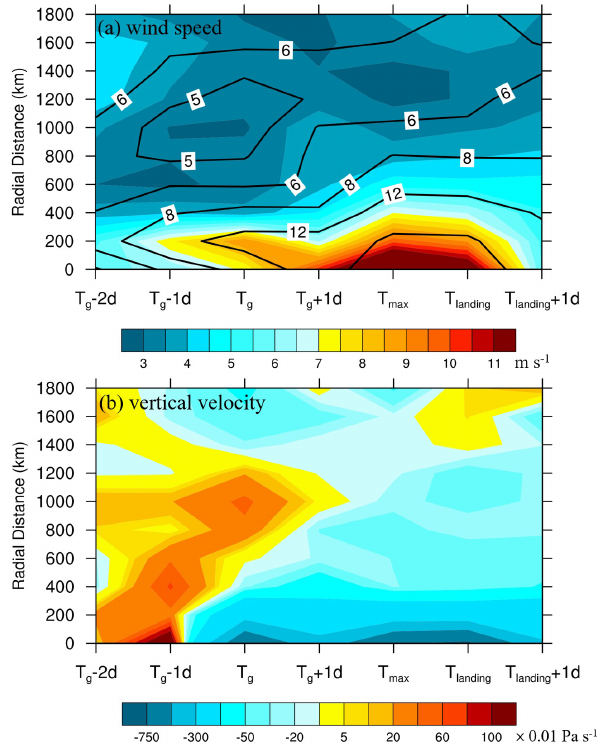
Figure 4. Same as Fig. 3b–c but for night-time (02:00LST). T landing stage and the T landing + 1 d stage respectively relative to ozone concentrations in the T g − 2 d stage.